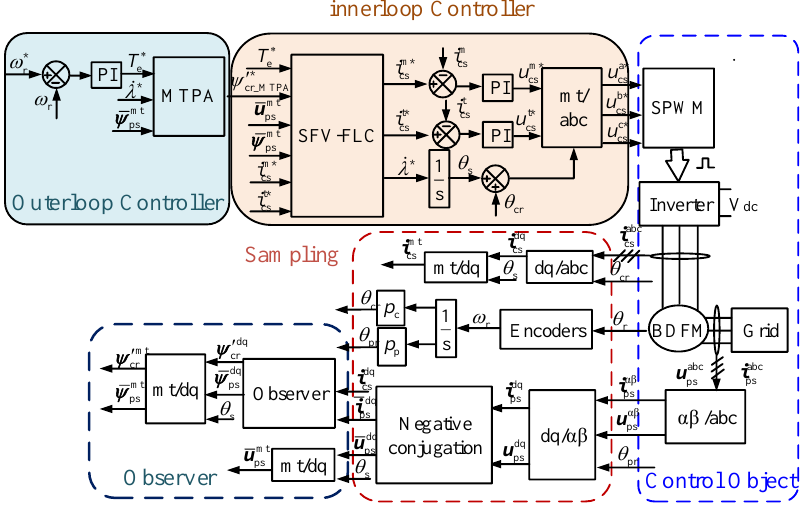
Figure 3. MTPA-(SFV-FLC) optimized control block diagram.